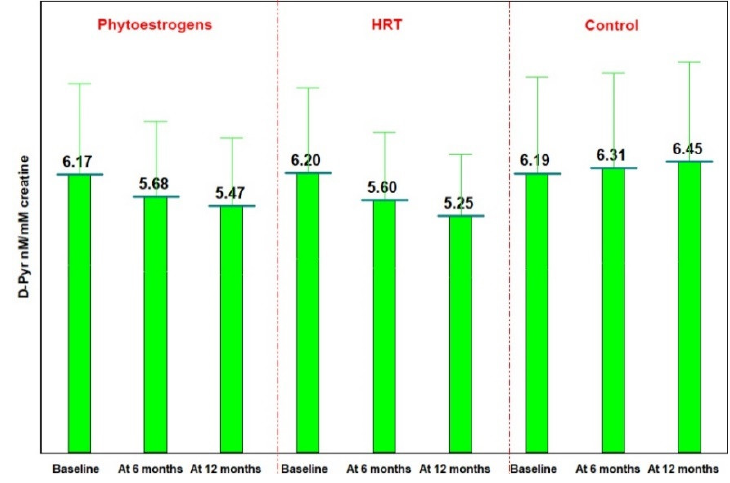
Figure 2. The evolution of averages values of D-Pyr.